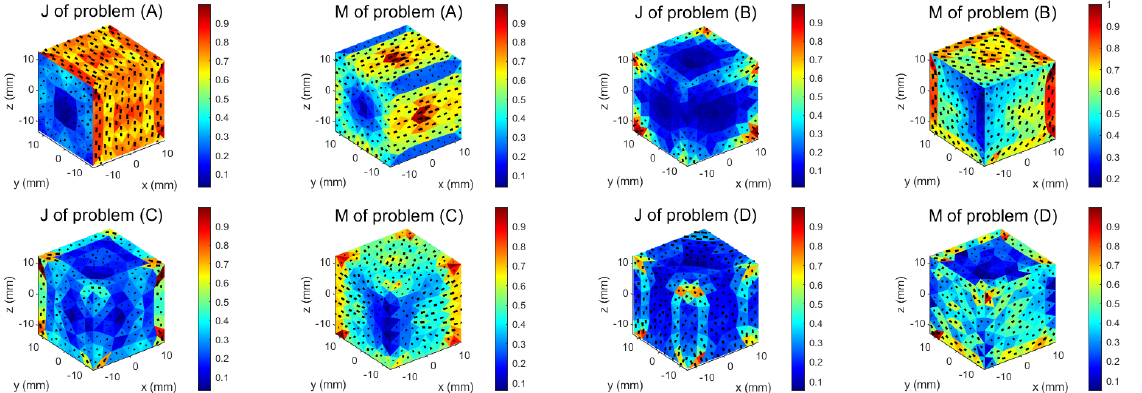
Figure 8. Characteristic electric and magnetic current distributions of mode 2 at 2.0 GHz, where the left column represents electric current and the right column represents magnetic current in every sub-figure.